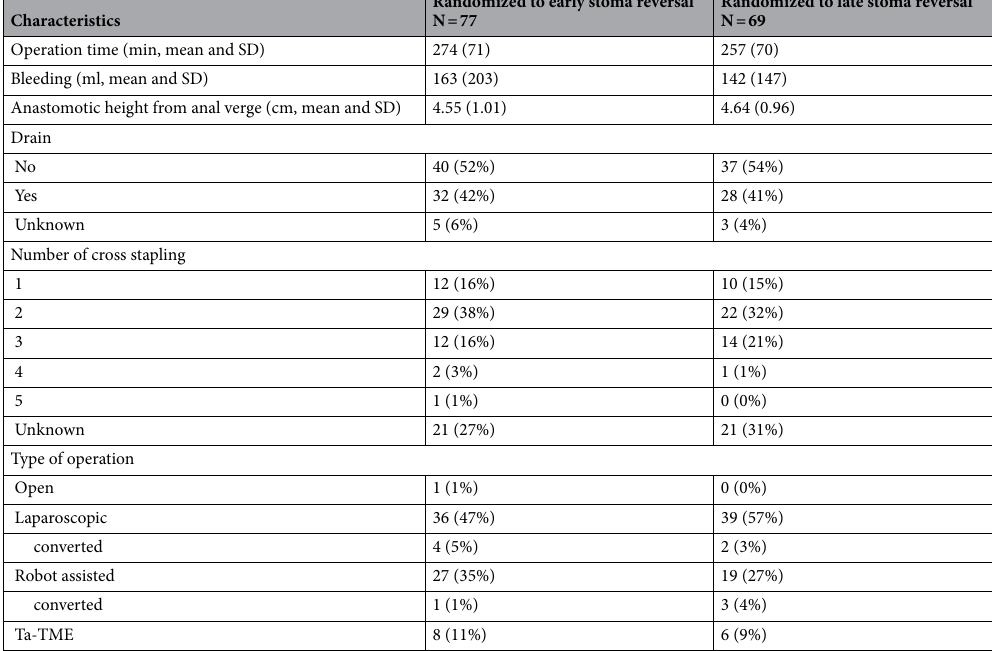
Society of Anesthesiologists; pT, Pathological tumour stage; pN, Pathological lymph node stage; cM, Clinical metastatic stage; Ta-TME, Transanal total mesorectal excision. *Maximal recommended limits of alcohol intake (units per week): males = 14 and females = 7 (Danish Health